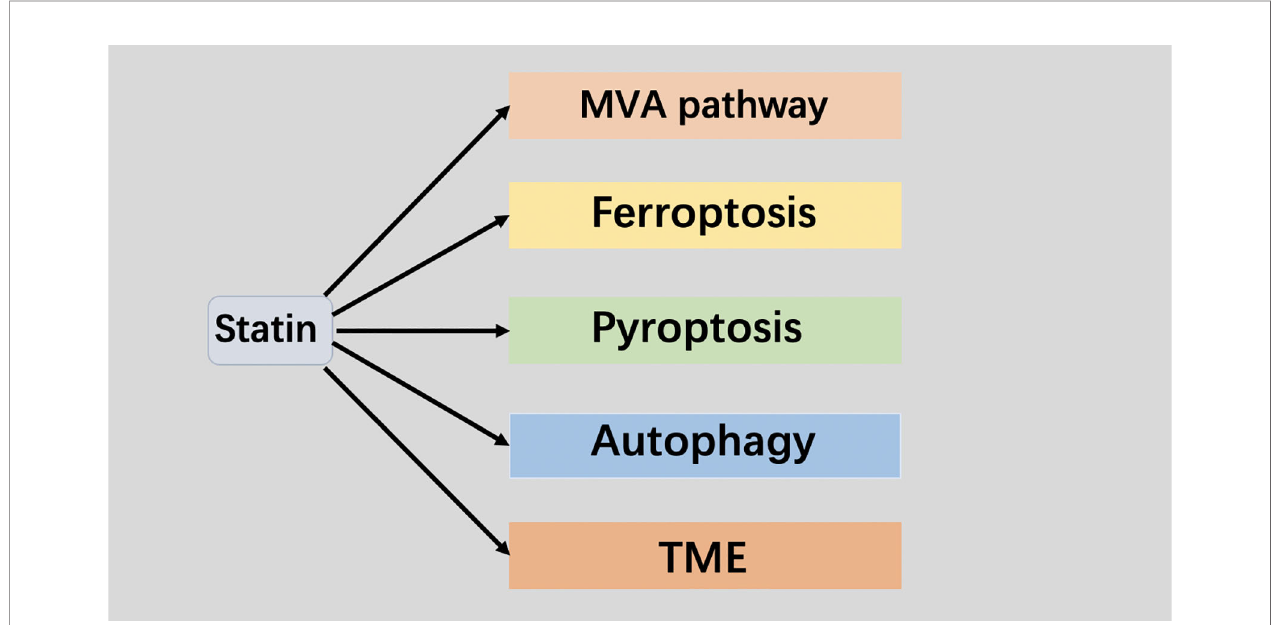
FIGURE 2 | Statin targets in cancer